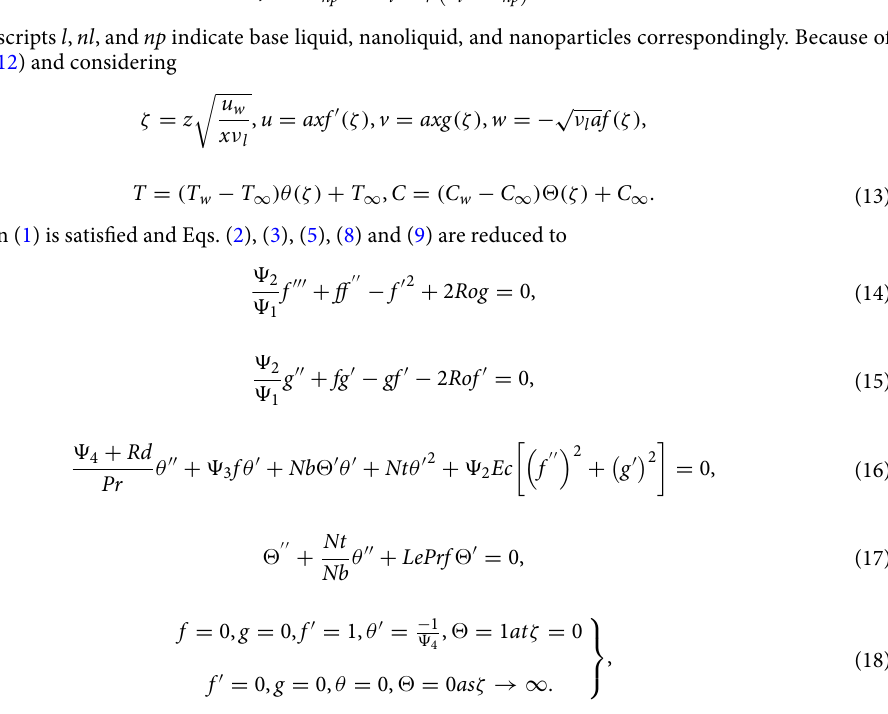
( C p µ ) l k l = ( ρ C p ) ( T w ) T np D T − Nt ∞ (thermo- ( ρ C p ) ν l = l T ∞ 16 α T 3 ∞ 3 k l β (thermal radiation =